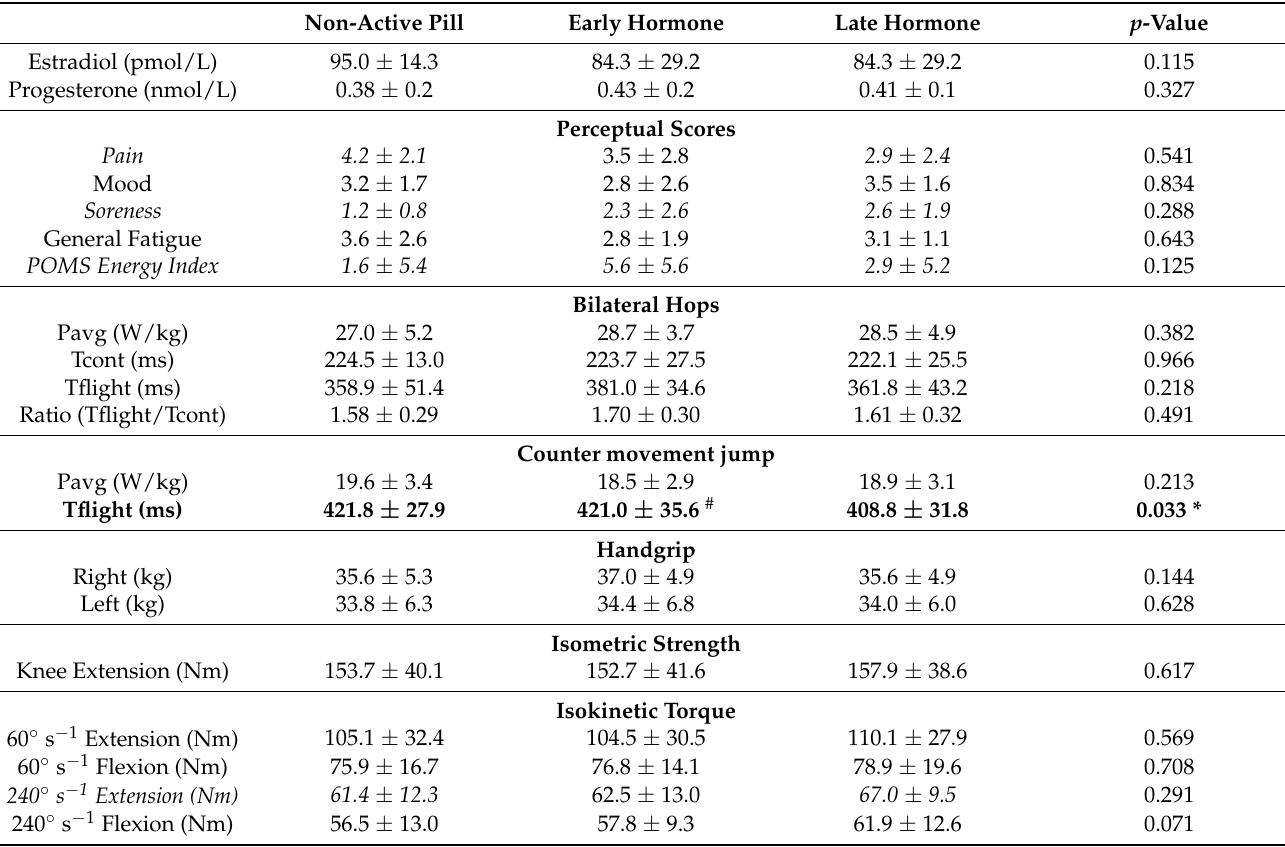
Table 3. Hormone concentrations, perceptual and muscle function measures for the low-androgenicity Oral Contraceptive group ( n = 8) over the three phases of the oral contraceptive